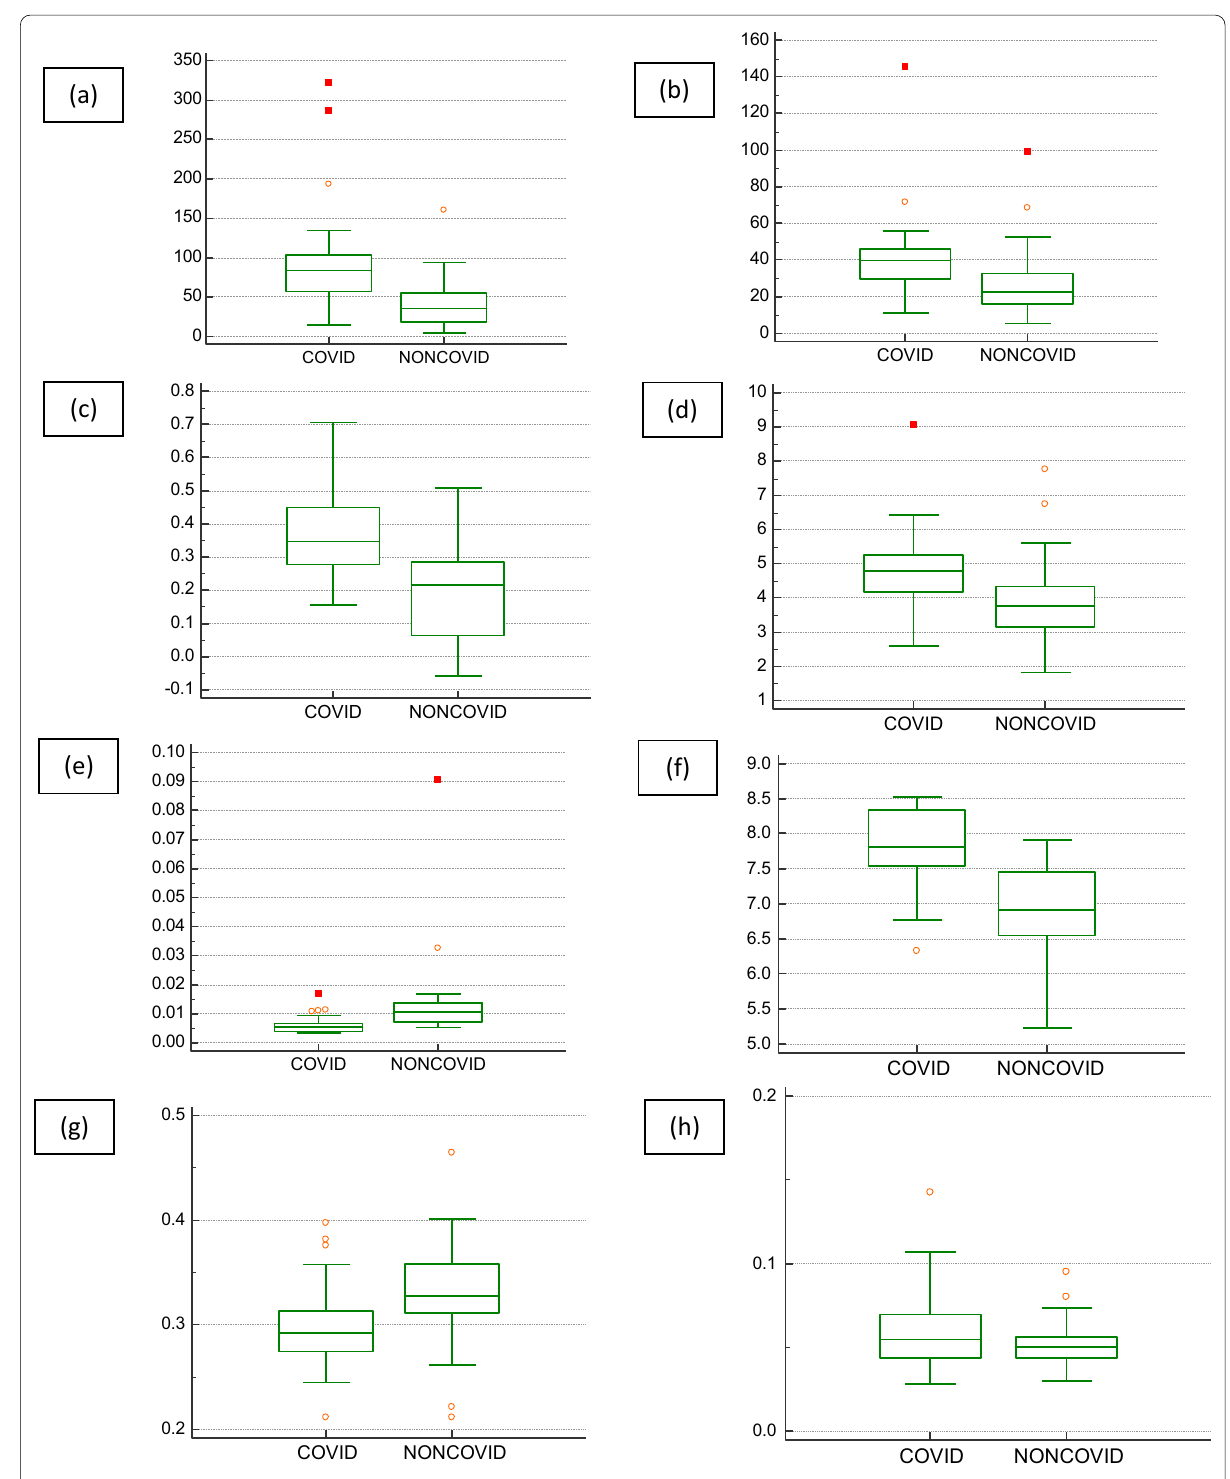
Fig. 2 Box and whisker plots for the associations between COVID-19 status and the CT scan-based radiomics features. ( a ) cluster tendency, ( b ) contrast, ( c ) correlation, ( d ) dissimilarity, e energy, f entropy, g homogeneity and h gray-level